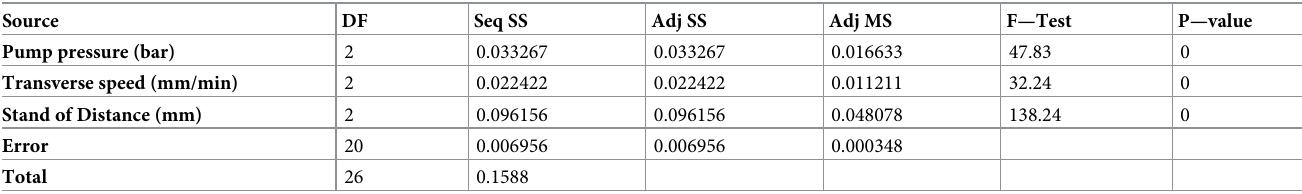
Table 4. ANOVA for glass fibre epoxy